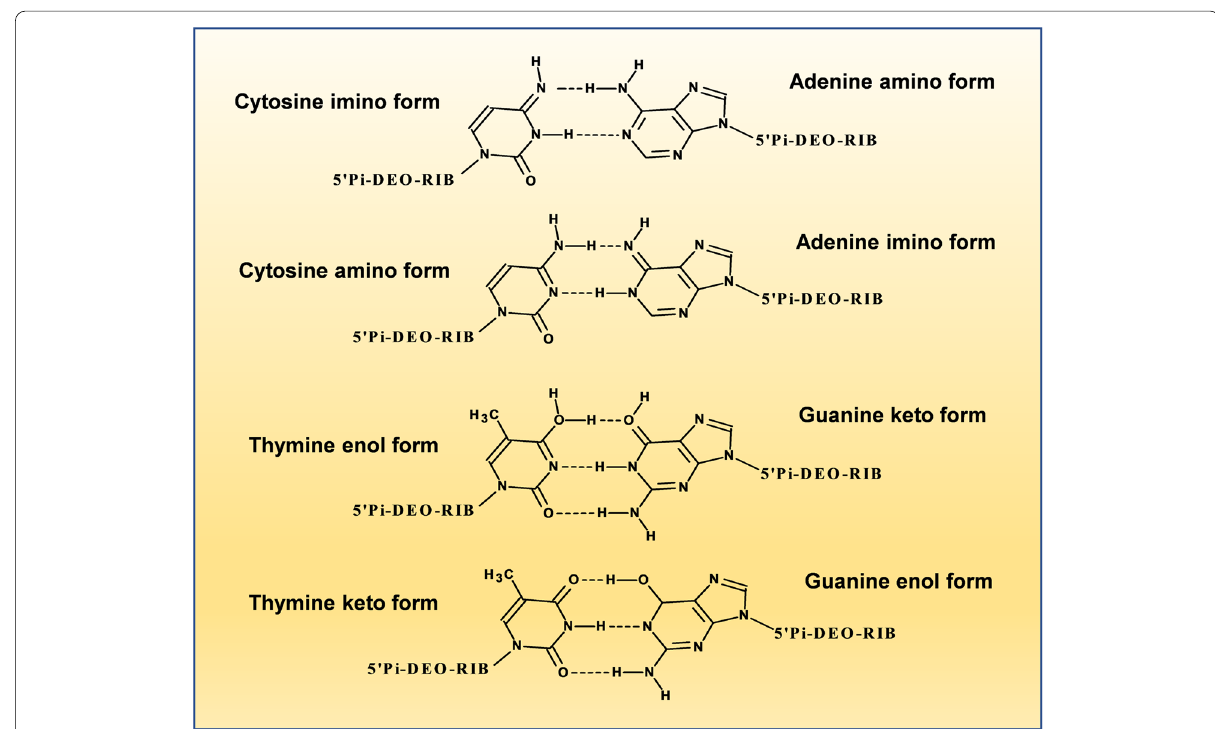
Fig. 4 Pairing of Adenine and Guanine tautomers in DNA. Adenine (amino‑imino) and Guanine (keto‑enol) tautomers paring with tautomeric forms of Cytosine (amino‑imino) and Thymidine (keto‑enol), respectively (based and modified from [85])